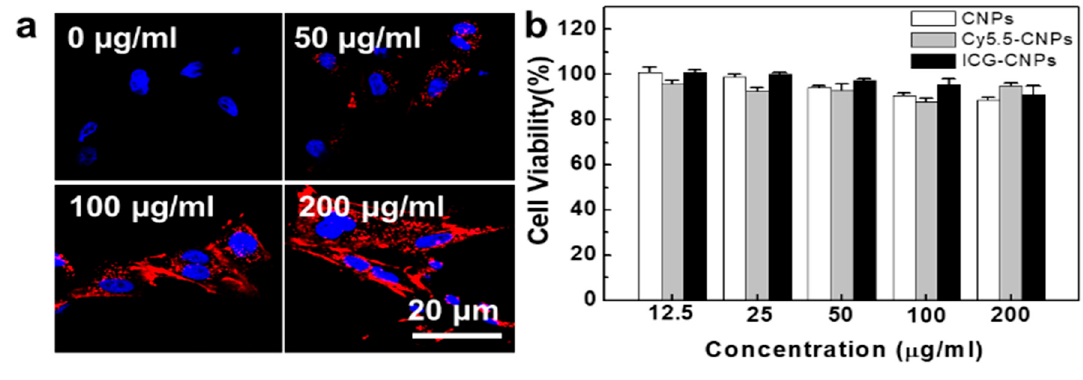
Figure 2. In vitro cellular uptake and cytotoxicity of CNPs in VX2 tumor cells. ( a ) Confocal microscope images of VX2 tumor cells after treatment with Cy5.5-CNPs (0 to 200 µ g / mL). Blue channel = DAPI, red channel = Cy5.5-CNPs. ( b ) Cell viability of VX2 tumor cells treated with CNPs, Cy5.5-CNPs, and ICG-CNPs for 24 h. ( n = 5).